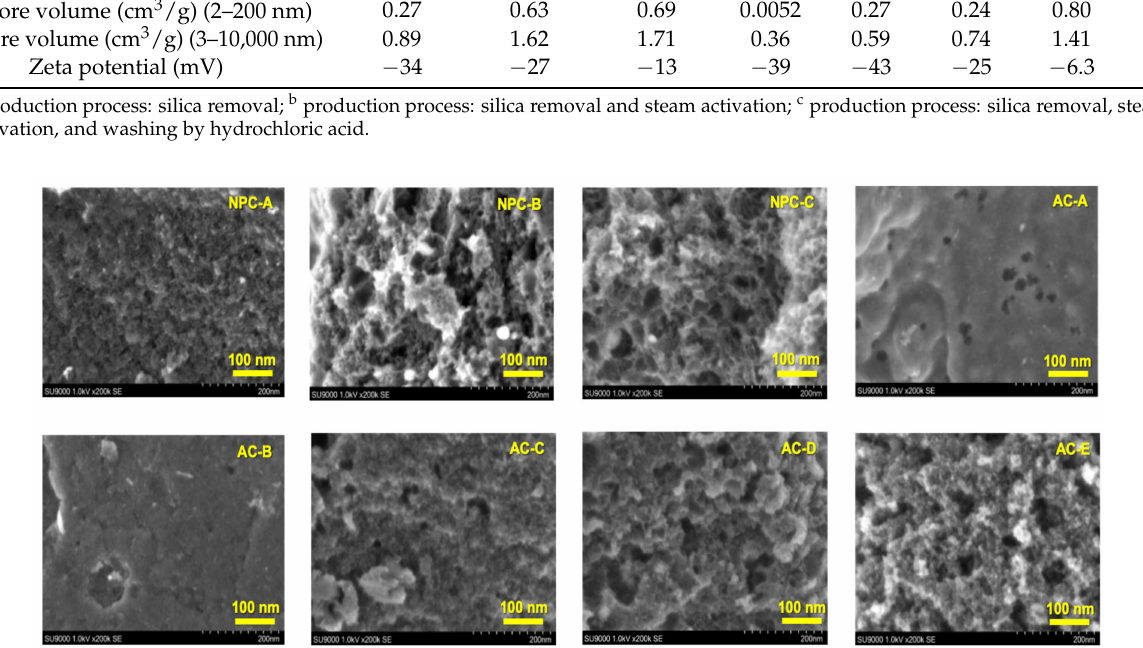
Figure 1. SEM images of different porous carbon adsorbents (before the virus adsorption) at a magnification of